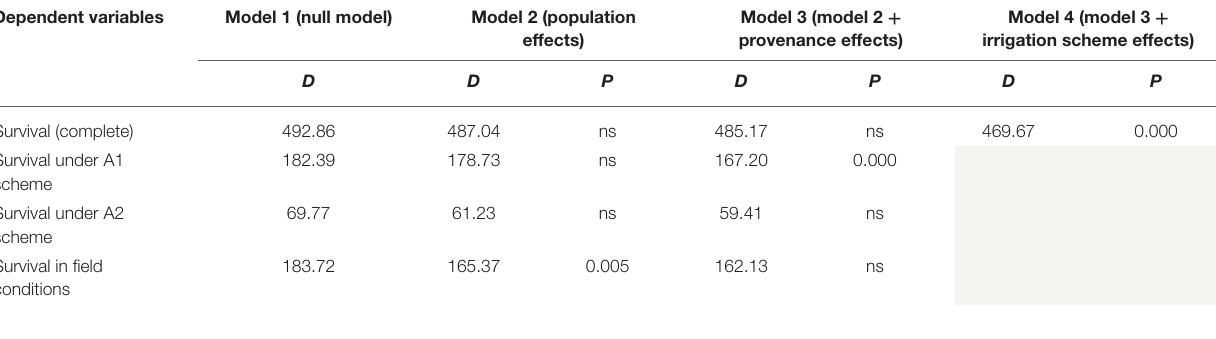
TABLE 2 | Model comparisons of the HLM models for the survival data via LRT (D: likelihood ratio statistic; P: p-value of the statistical significance of LRT test).